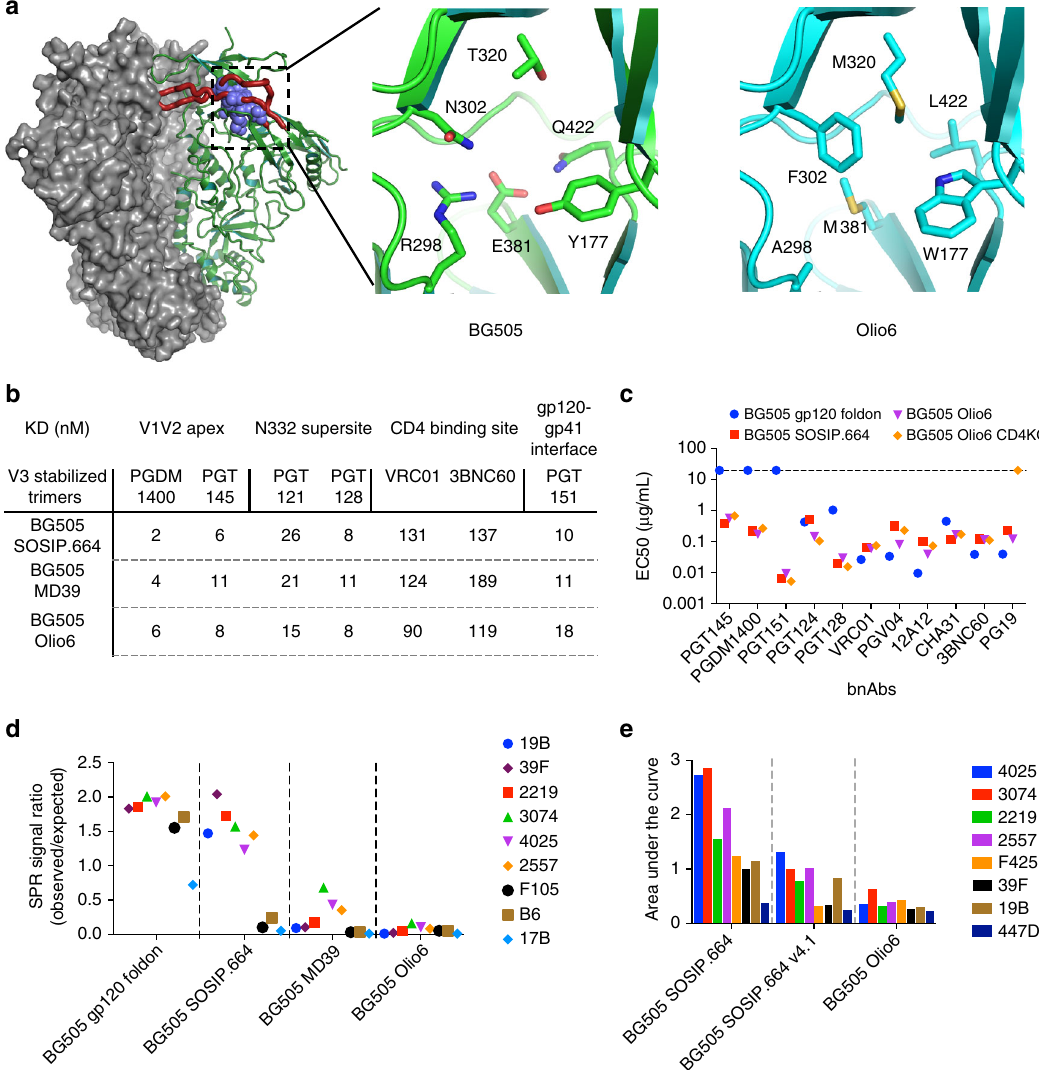
Fig. 1 Structure-based design of BG505 Olio6 trimer. a Structural model of BG505 SOSIP.664 trimer (PDBID: 4TVP), with two subunits shown as a grey surface, one subunit shown as green trace. The V3 loop is shown as a thick red trace and the six substituted positions are shown as slate spheres. The enlarged frames show the six substituted positions in sticks, in green are the BG505 amino acids and in cyan are the corresponding Olio6 amino acids. b Binding af fi nities of bnAbs as measured by SPR are shown for BG505 SOSIP.664, BG505 MD39, and BG505 Olio6. The K D s for V1V2 apex bnAbs were measured with trimer analyte and IgG ligand, but for other bnAbs Fab analyte and trimer ligand were used. c bnAb EC 50 values were measured by ELISA for stabilized trimers. When an EC 50 could not be determined, the symbol was placed at the highest concentration tested (20 μ g/mL). d Binding of non-nAbs to trimers measured by SPR. Trimers were analytes at 1 μ M. The SPR signal ratio is the observed response normalized to the expected response of one gp120 per antigen-binding site. e Binding of V3 non-nAbs to trimers by ELISA. BG505 SOSIP.664 v4.1 is reported in de Taeye et al. 2015 26 . The Area Under the Curve has units of Abs 450 nm×log(dilution). Measurements are done in duplicate and represent two independent